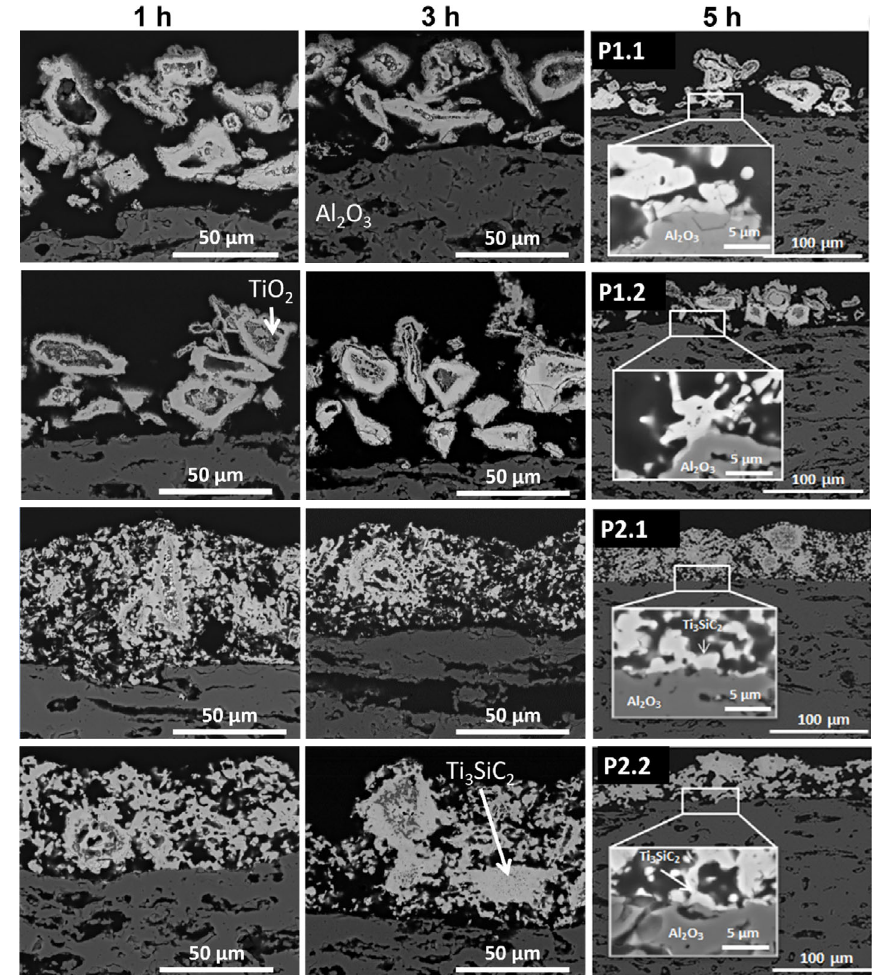
Fig. 6 SEM micrographs of the sintered screen printed layers of all paste compositions at 1400 ℃ in argon.